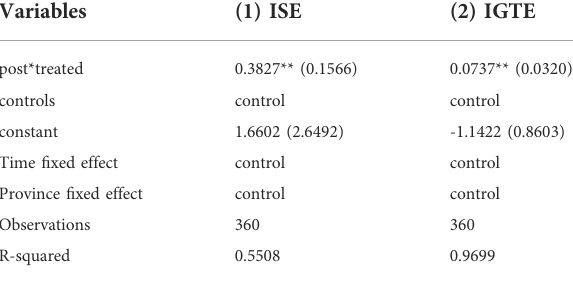
TABLE 5 Robustness test: add control